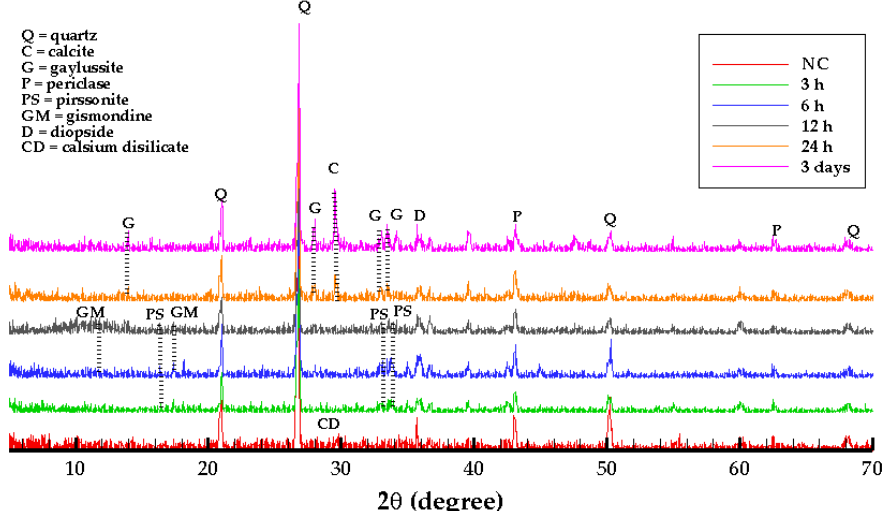
Figure 8. XRD diffractograms of non-carbonated and carbonated samples .